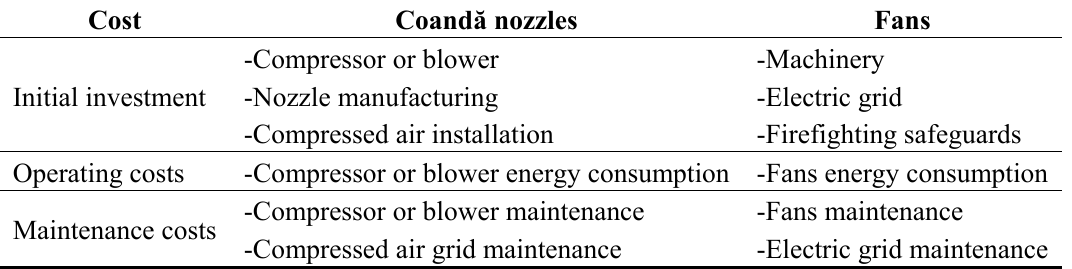
Table 1. Comparison between Coand ă nozzles and fans main